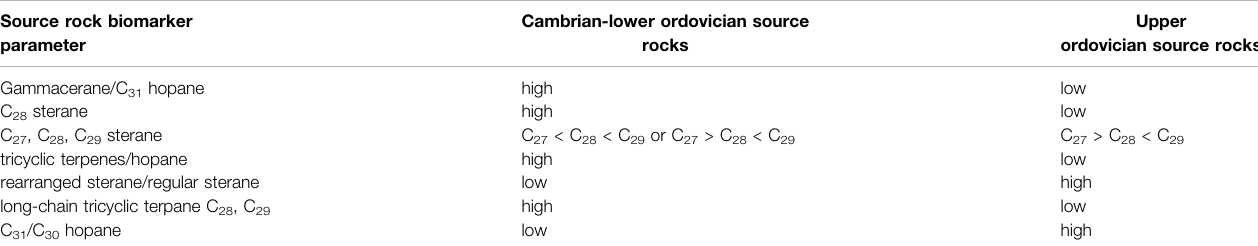
TABLE 1 | Comparison of source rock biomarking parameters between middle and lower cambrian — lower ordovician and upper